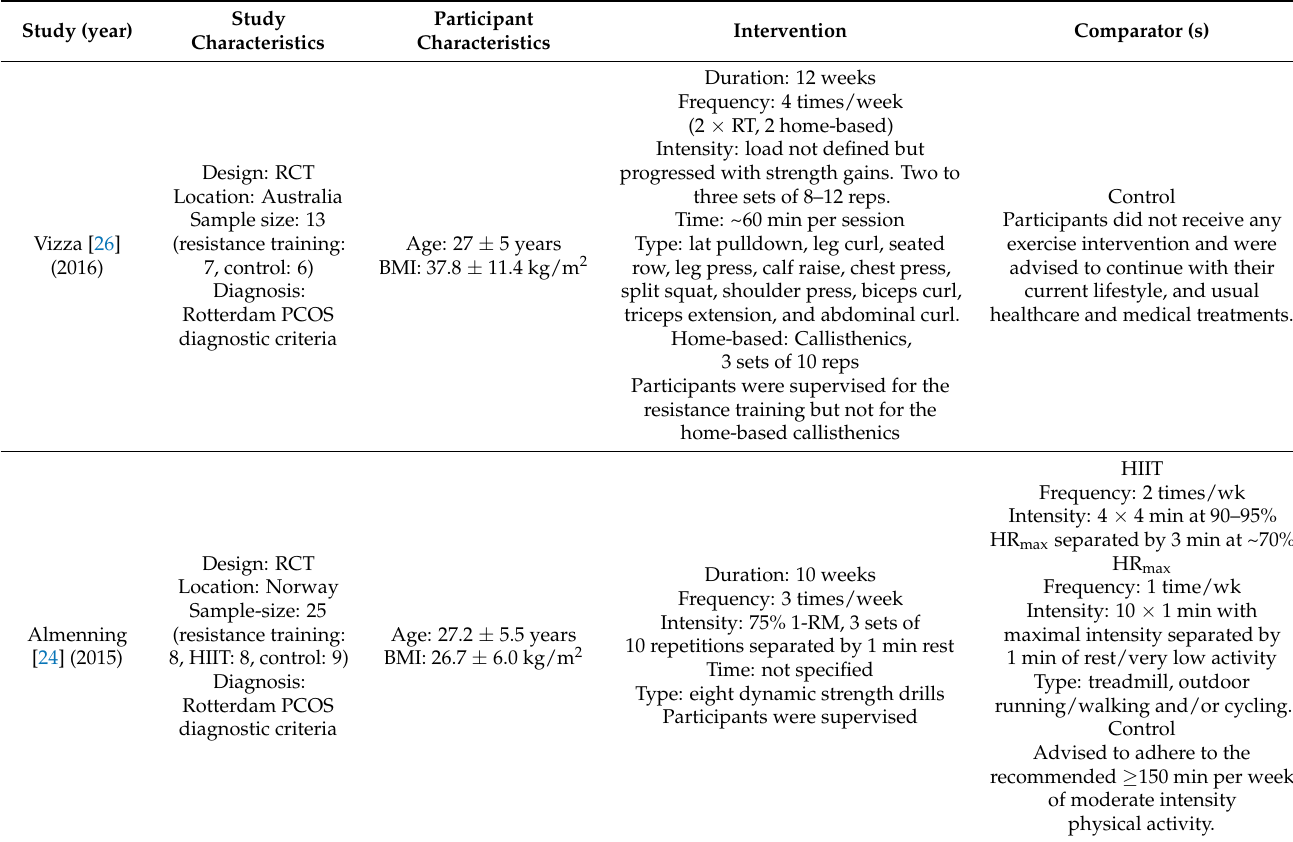
Table 3. Characteristics of studies included in this scoping